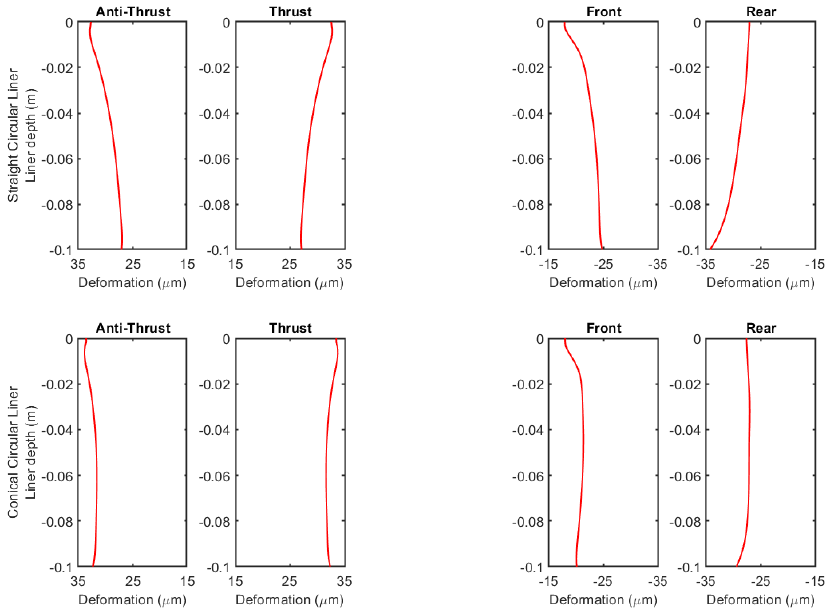
Figure 4. Bore deformation for straight ( top ) and conical circular liners ( bottom ) for the hot operation case.